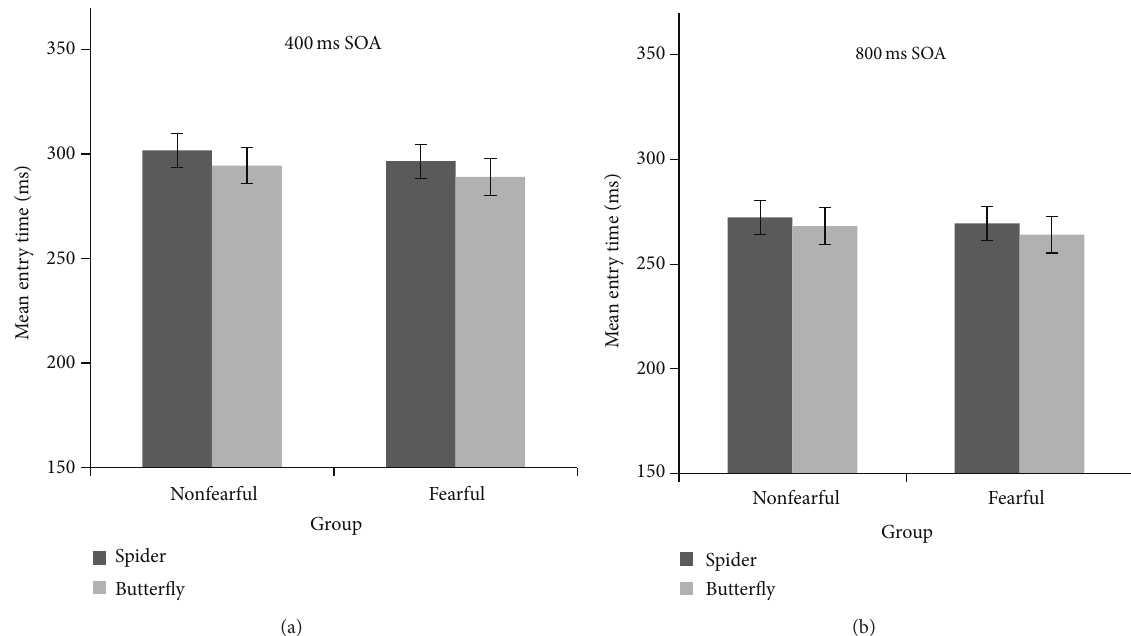
Figure 3: Eye-tracking data—mean entry time on target area in milliseconds for the control group and spider fearful group for the 400ms SOA (a) separately for spider and butterfly targets and for the 800 ms SOA (b). Bars represent the standard error of the mean.